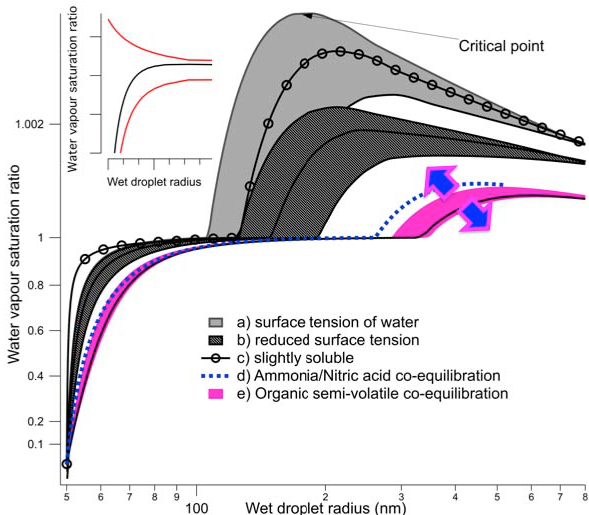
Fig. 1. Three representations of K¨ohler theory for a 50nm dry parti- cle, comparing traditional K¨ohler theory without (grey shaded area) and with (hatched surface area) an (unrealistically large) influence of surface active material assuming the surface active molecules do not reduce the Raoult effect, and our new formulation which al- lows the co-condensation of any number of compounds (coloured area). Above a saturation ratio of 1 the axis scale has been changed to more clearly display the critical point. Each area is constructed by changing the properties of a core (comprising 30% of the con- densed mass at 0%RH) from insoluble organic compound with molecular weight of 320gmol − 1 to ( NH 4 ) 2 SO 4 , with the solid line through each area representing a soluble compound with molecu- lar weight of 320gmol − 1 , (in each case, moving from the insolu- ble compound to ( NH 4 ) 2 SO 4 decreases the critical saturation ratio, S crit ). Circle markers represent the assumption of a slightly soluble shell using conventional K¨ohler theory. The dashed blue line rep- resents co-equilibration of Ammonia and Nitric acid for brief com- parison to the work of Kulmala et al. (1993). In this instance the equilibrium constants were taken from Seinfeld and Pandis (1998) and the core assumed to be ( NH 4 ) 2 SO 4 to obtain the lowest S crit . Equilibration of multiple semi-volatile components results in by far the largest decrease in critical supersaturation and increase in cloud droplet forming behaviour, by increasing the soluble mass as the RH increases, towards activation. The actual amount of soluble mate- rial condensing per particle will depend on the size distribution and number concentration. As all simulations at 0%RH correspond to a number concentration of ∼ 600/cc in this example, the multicolored arrows indicate the direction the coloured areas would follow on in- creasing and decreasing the concentration of particles. The shape of the size distribution, concentration, volatility profile and amount of condensable material will dictate this final result, a solution of the condensation dynamics the focus of future work. The small in- set at the top left of the figure is a simple schematic displaying the contribution of the Raoult (bottom red line) and Kelvin terms (top red line) to the resulting K¨ohler curve (black line). The Kelvin term asymptotically approaches infinity as the size tends to zero.